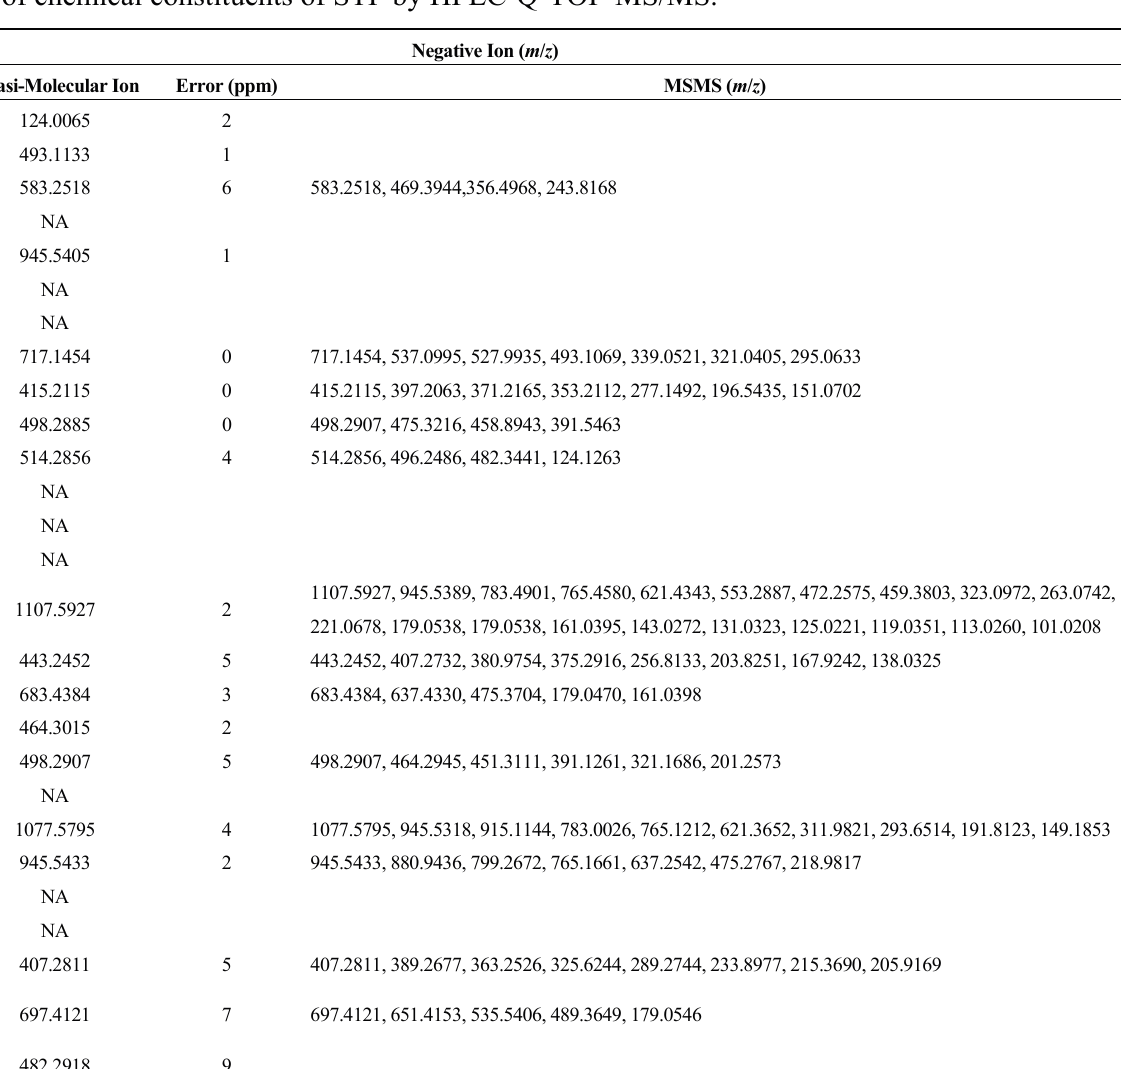
Table 1. Characterization of chemical constituents of STP by